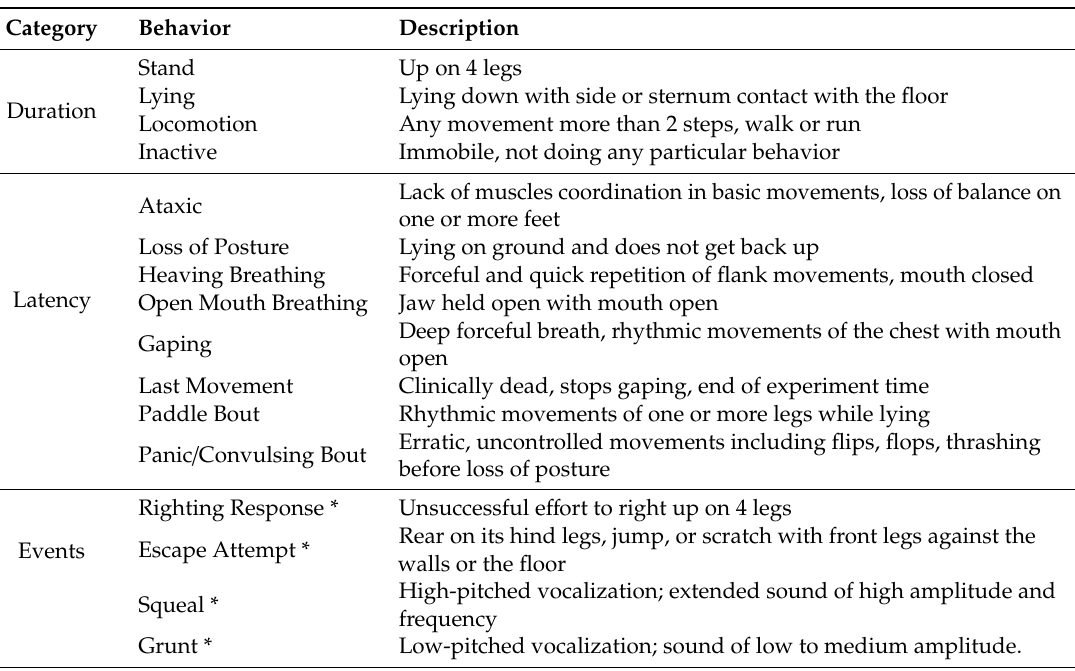
Table 1. Behavioral states and events recorded during euthanasia. Interruptions shorter than 3 s were considered the same bout of behavior. Behavioral recording started when the gas was turned